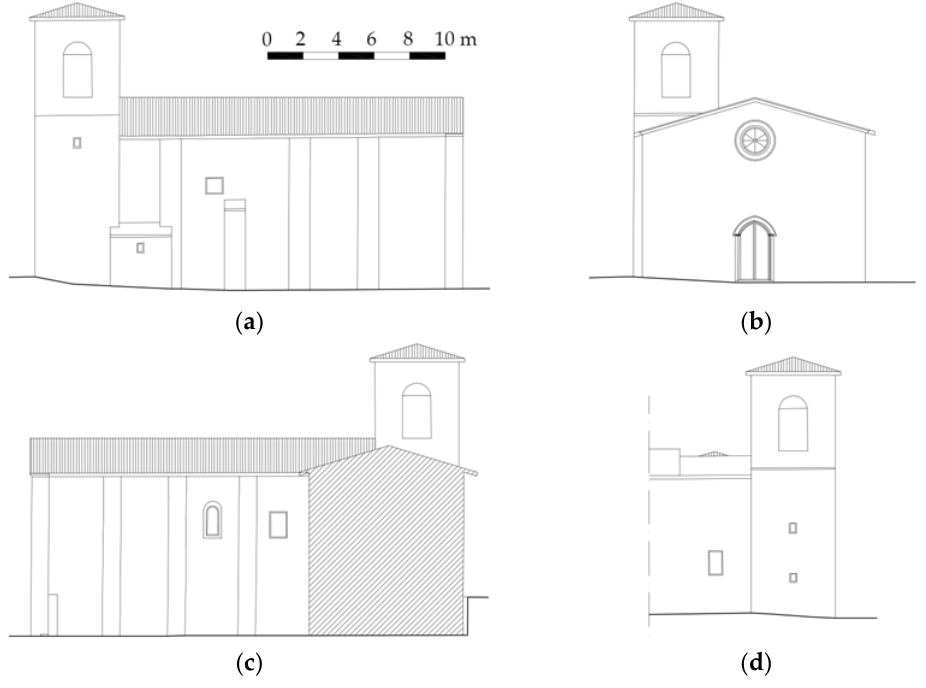
Figure 5. Geometrical survey of the church [47]. ( a ) North elevation of St. Salvatore church; ( b ) principal (west) façade of St. Salvatore church; ( c ) south elevation of St. Salvatore church; ( d ) east elevation of St. Salvatore church.